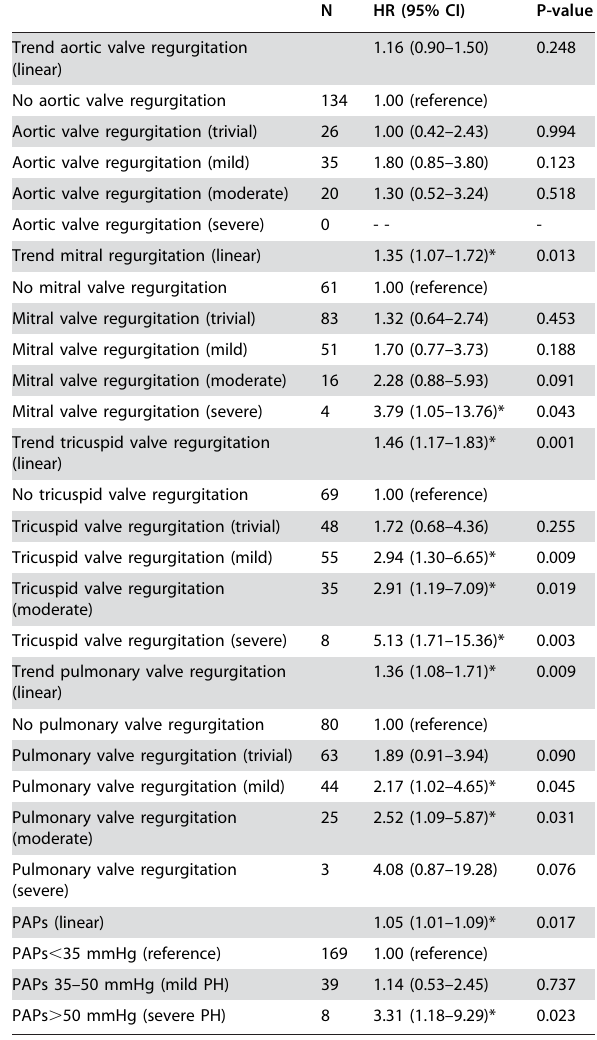
Table 4. Trend Analysis of Hazard Ratio of a Fall and Aortic, Mitral, Tricuspid and Pulmonary Valve Regurgitation (N =215). .. ... .... ... ... .... ... ... .... ... ... .... ... ... .... ... ... .... ... ... ....